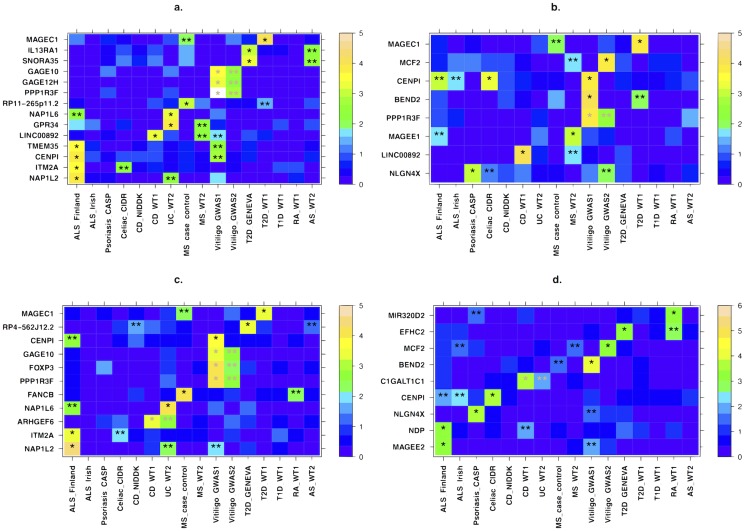
X-linked genes associated with autoimmune disease risk.All genes that showed evidence of association in a gene-based test and replication, including suggestive replication in any other dataset (see main text) are presented for the a) FMS.comb b) FMF.comb c) FM02 and d) sex-differentiated effect size tests (Materials and Methods). X-axis denotes the different datasets, with their names following the notation from Table 1. Y-axis displays the different gene names. For each gene, the more significant p-value of the truncated tail strength and truncated product methods is displayed on a −log10 scale according to the enclosed color scale. A “*” represents the discovery dataset and “**” indicates datasets in which replication is significant after correcting for the number of genes tested for replication. These appear in grey when the discovery and replication are in datasets of the same disease (or across the related Crohn's disease and ulcerative colitis). Numerical values corresponding to this figure are presented in Tables 2–3.